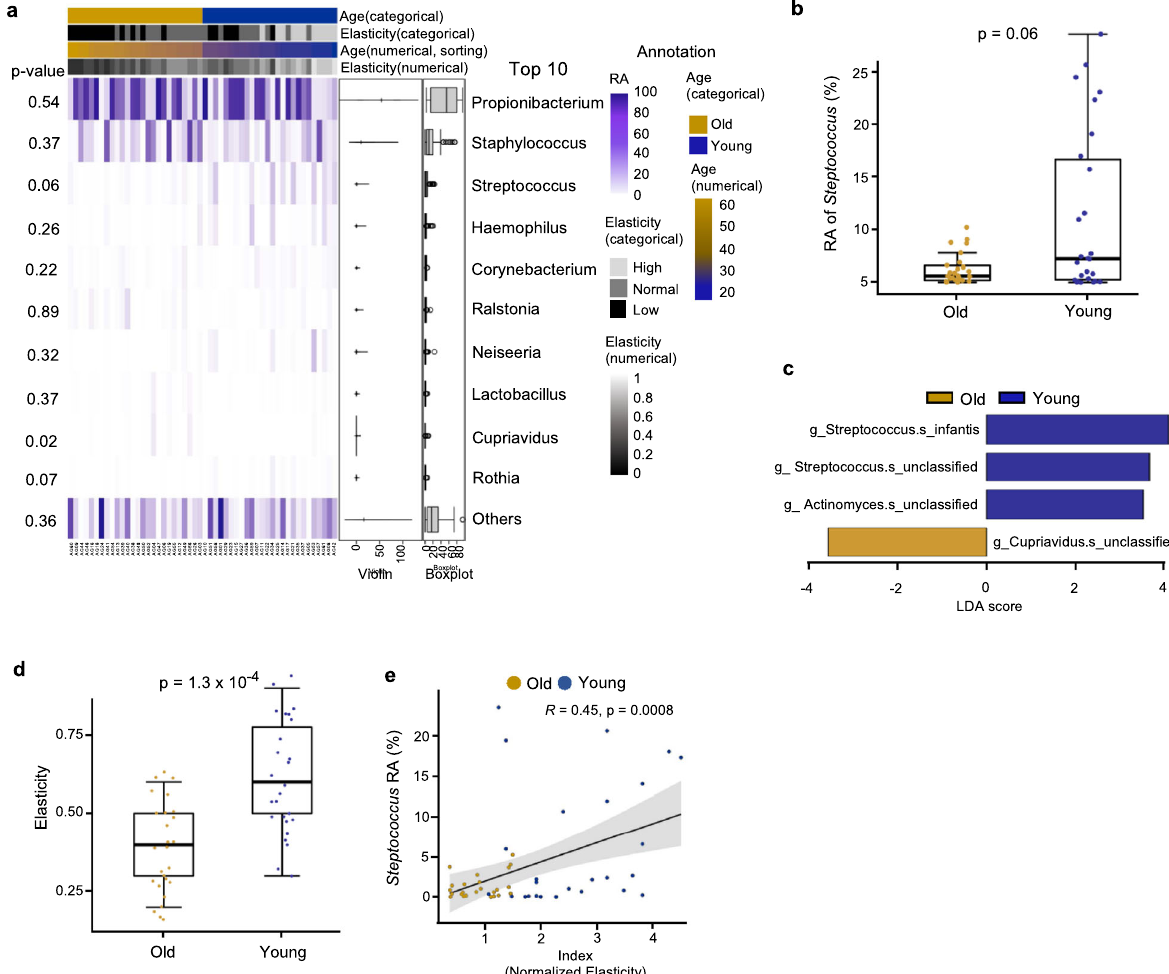
Fig. 1 Streptococcus species are the potential to anti-aging of skin. a Relative abundance (RA) of facial skin microbiome at the genus level including some clinical information. The top 10 most abundant genera are presented. Violin plot and boxplot show the RA of each skin microbiome with the columns sorted by age. b Boxplot illustrating the RA of the Streptococcus genus in old ( n = 26) and young ( n = 26) participants. c Taxonomic plot of LDA scores from LEfSe, illustrating the sequenced microbiome that differed signi fi cantly at least at the genus level between the old and young group (|LDA score| > 3.5); g, genus; s, species. d Boxplot illustrating the elasticity index of the old and young groups. Wilcoxon – Mann – Whitney test and Pearson correlation test were used for statistical analysis. e RA of Streptococcus versus normalized elasticity index of the old and young